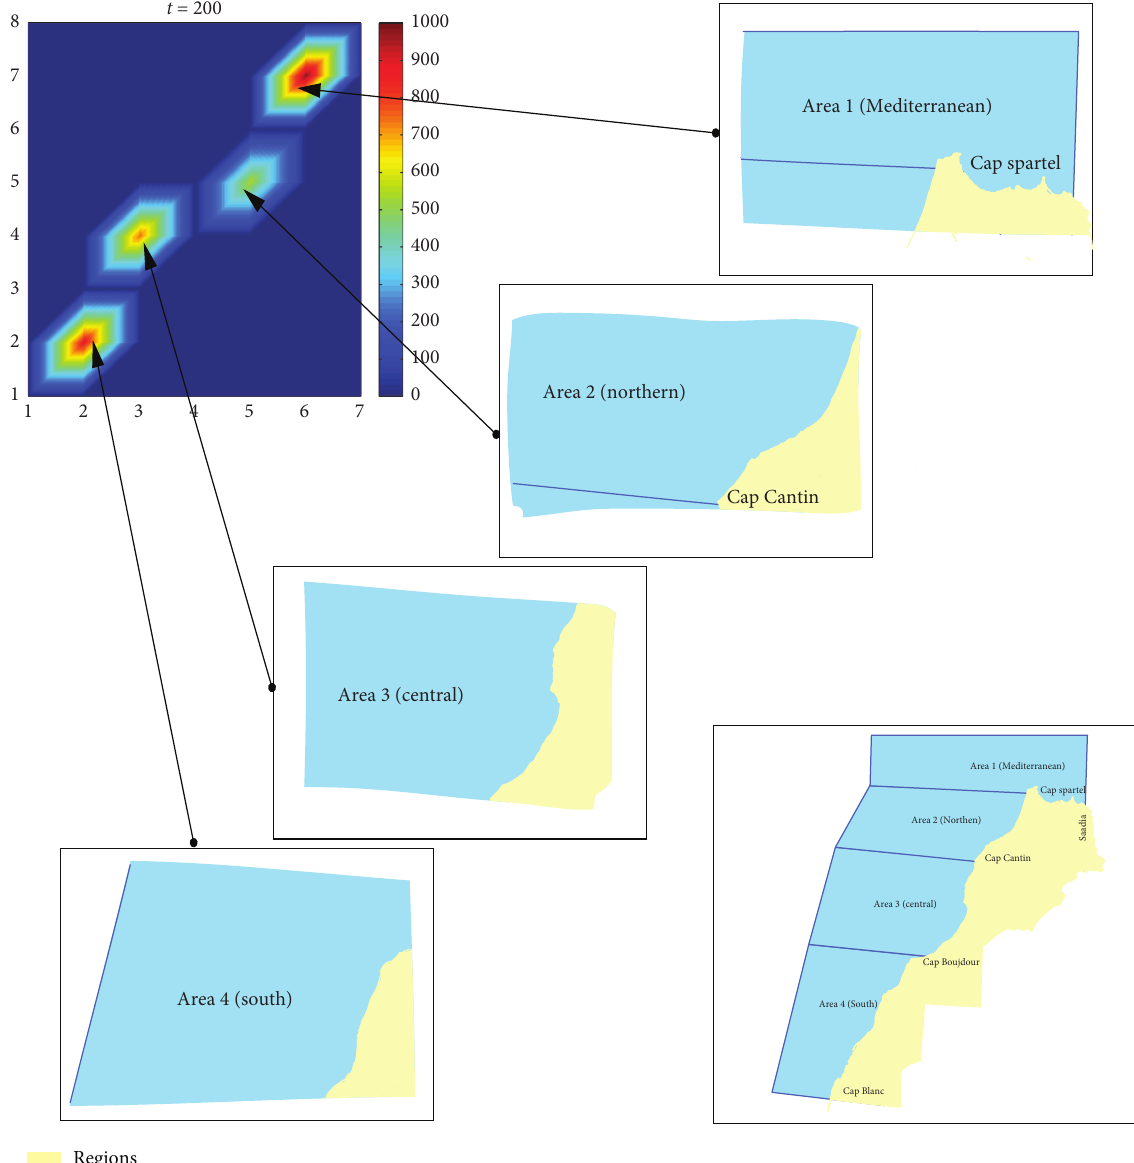
Figure 3: Our numerical simulation based on four major fishing areas in Morocco: (area 1): the Mediterranean area between Saadia and Cape Spartel; (area 2): the northern area between Cape Spartel and Cape Cantin; (area 3): the center area between Cape Cantin and Cape Boujdour; (area 4): the southern area between Cape Boujdor and White